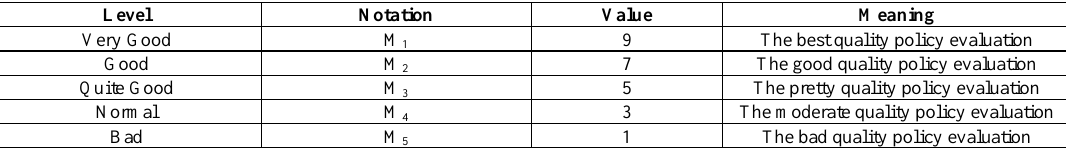
Table 3. The rating scale of the policy's quality.